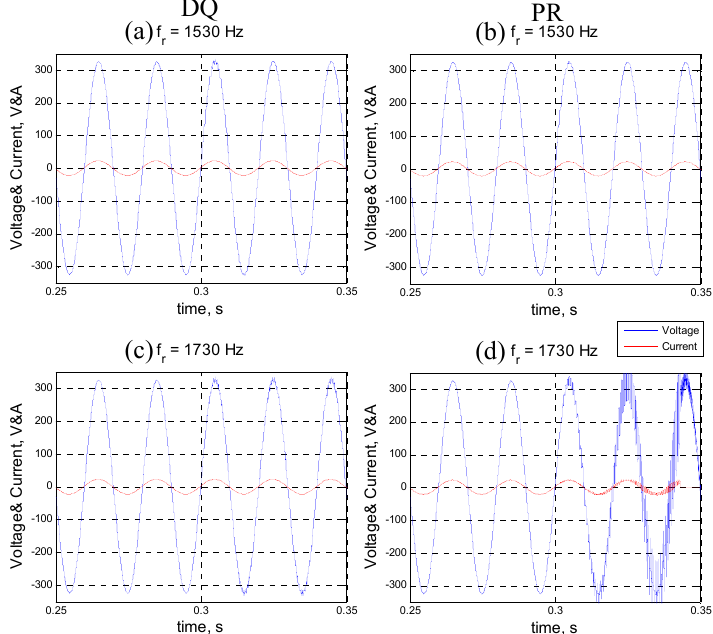
Figure 12. The simulation waveform result of ( a ) dq-based control method with a 1530 Hz resonant frequency; ( b ) PR-based control method with a 1530 Hz resonant frequency; ( c ) dq-based control method with a 1730 Hz resonant frequency; ( d ) PR-based control method with a 1730 Hz resonant frequency.